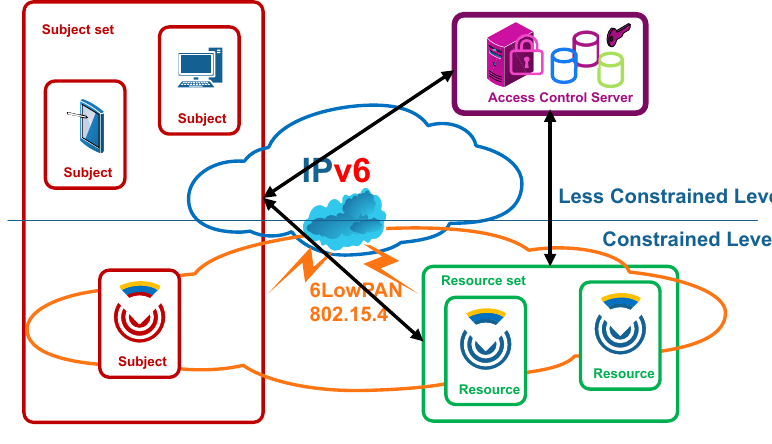
Figure 2. Access control